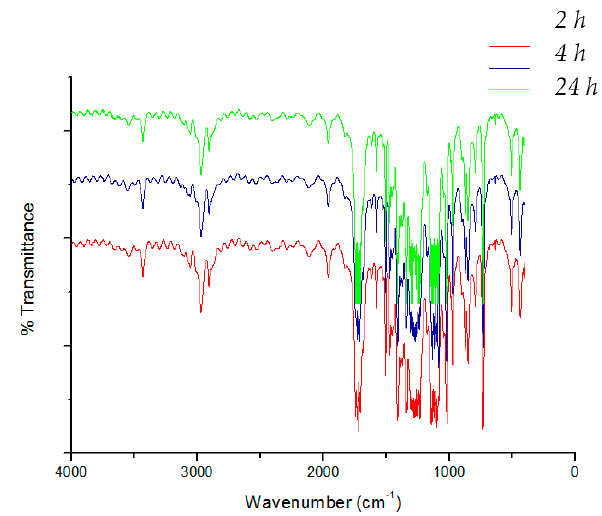
Figure 1. FT-IR spectra of ( a ) PET and whey/sorbitol samples; ( b ) PET/whey sorbitol after washing, respectively, for 2 h, 4 h, and 24 h.